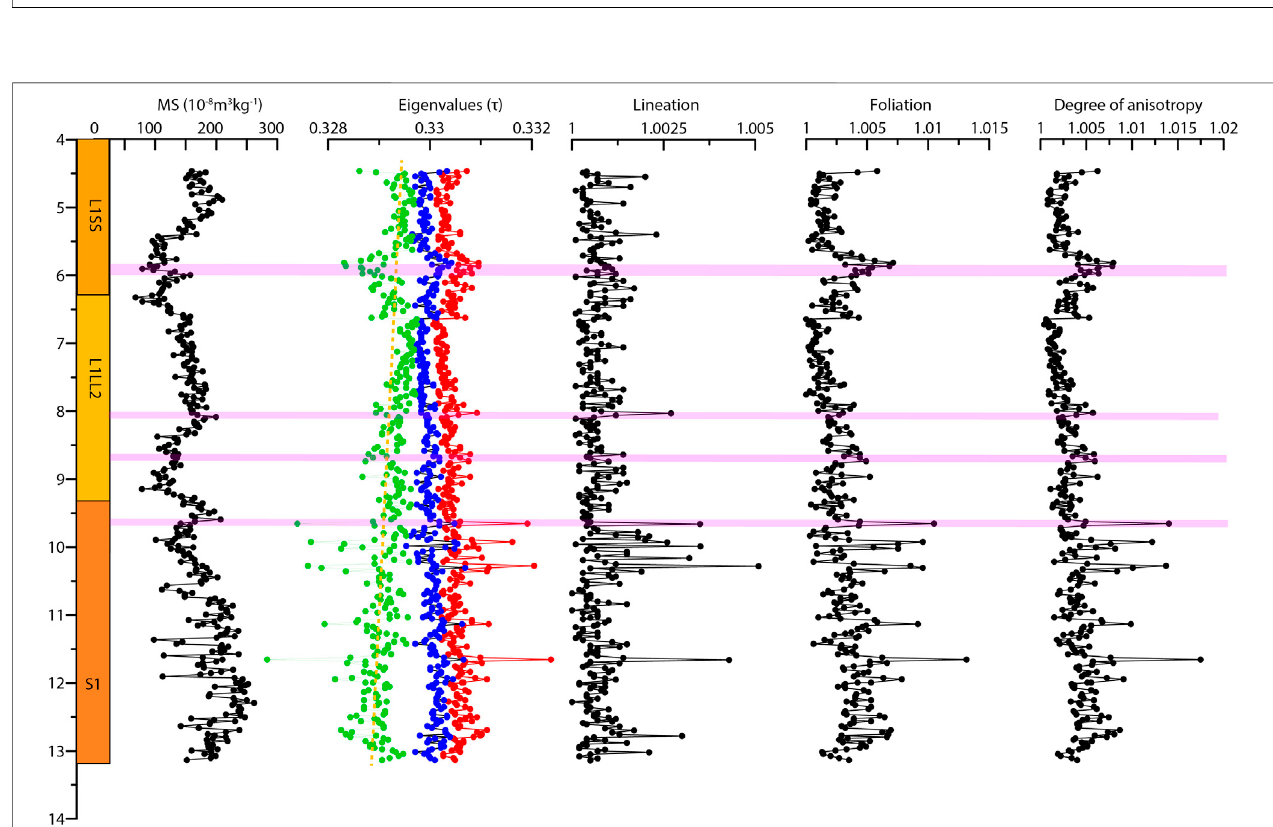
FIGURE 5 | The depth vs. variation of magnetic susceptibility, eigenvalues of three principal anisotropy of magnetic susceptibility axes ( τ max in red, τ int in blue, and τ min in green), lineation (L), foliation (F), and degree of anisotropy (P) in the Xunyi section. Pink bars showing extreme or spurious cases with high P and F, related to high MS values and τ -max, and low τ -imin.